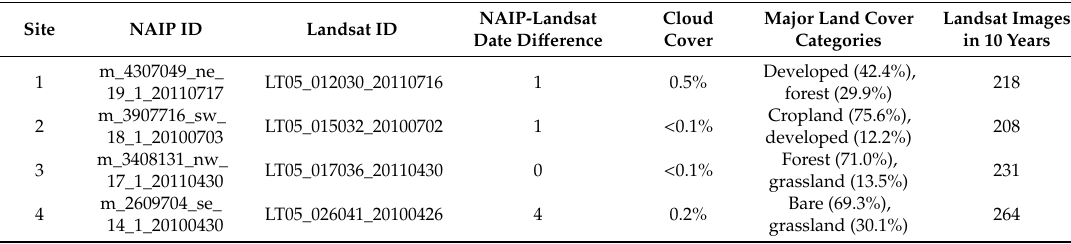
Table 1. Summary of four primary study